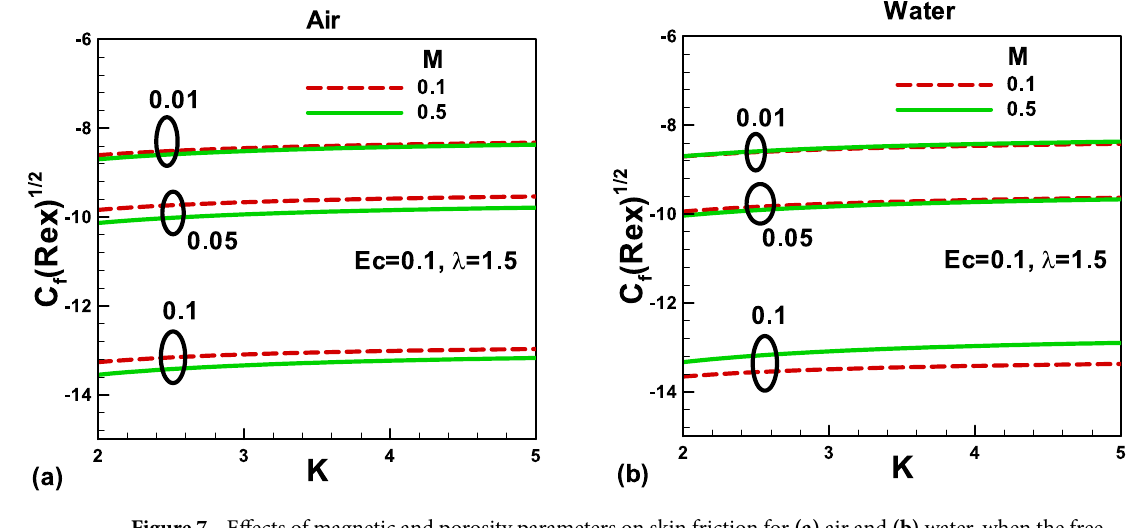
Figure 7. Effects of magnetic and porosity parameters on skin friction for (a) air and (b) water, when the free stream is moving along the negative x-axis and the needle is moving in the opposite direction.